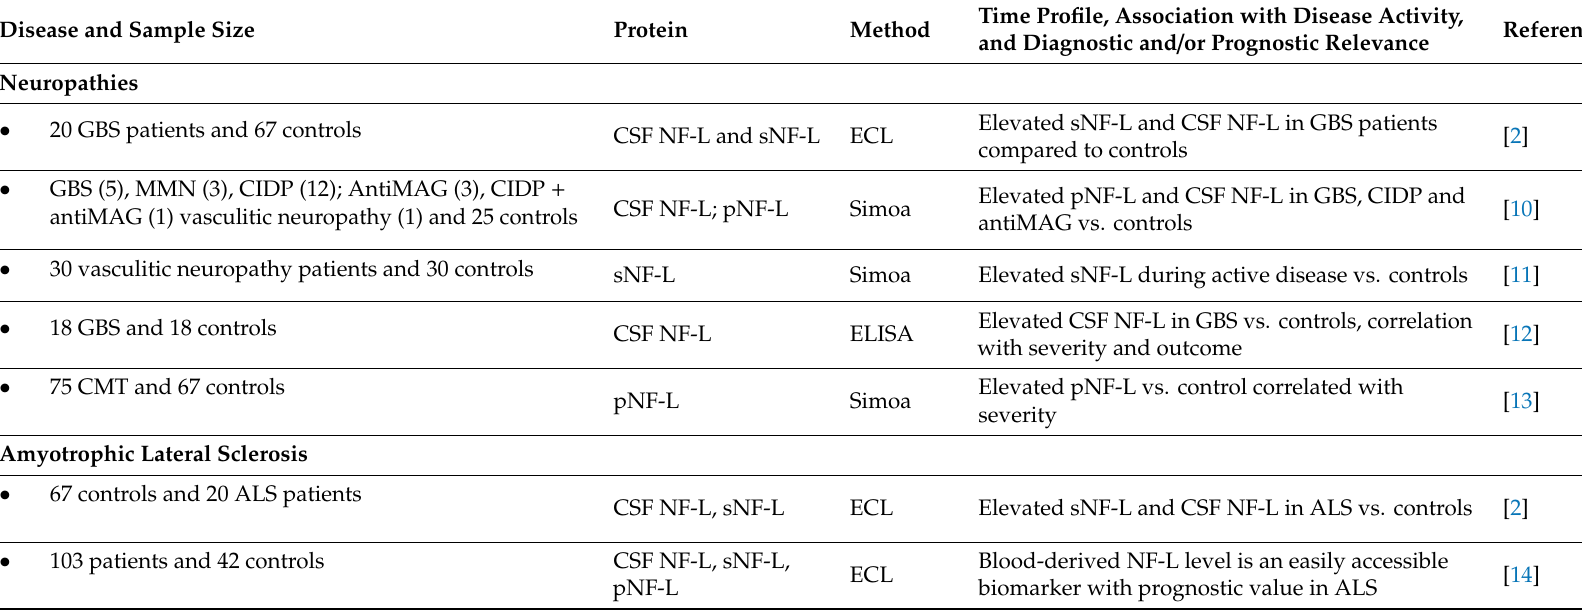
Table 1. Overview of neurofilaments as biomarkers of neurological disease. Abbreviations used in table: AD, Alzheimer’s disease; ADAD, autosomal dominant Alzheimer’s disease; AIS, acute ischemic stroke; ALS, amyotrophic lateral sclerosis; aMCI, amnestic mild cognitive impairment; aSAH, aneurysmal subarachnoid hemorrhage; CA, cardiac arrest; CADASIL, cerebral autosomal-dominant arteriopathy with subcortical infarcts and leukoencephalopathy; CBS, corticobasal syndrome; CeAD, cervical artery dissection; CIDP, chronic inflammatory demyelinating polyneuropathy; CMT, Charcot–Marie–Tooth; CSF, cerebrospinal fluid; ECL, electrochemiluminescence; FTD, frontotemporal dementia; GBS, Guillain–Barr é syndrome; GCS, Glasgow Coma Scale; HD, Huntington’s disease; HHT, huntingtin; HS, hemorrhagic stroke; MCI, mild cognitive impairment; MMN, multifocal motor neuropathy; MND, motor neuron disease; MS, multiple sclerosis; MSA, multiple system atrophy; NF-M, neurofilament medium chain; ON, optic neuritis; PD, Parkinson’s disease; pNF-L, plasma neurofilament light chain; p-pNF-H, plasma phosphorylated neurofilament heavy chain; PSP, progressive supranuclear palsy; ROSC, return of spontaneous circulation; RSSI, recent small subcortical infarcts; neurofilament light chain; SVD, small vessel disease; TIA, transient ischemic attack; WMH, white matter hyperintensities; WML, white matter lesions. Time Profile, Association with Disease Activity, Disease and Sample Size Protein Method and Diagnostic and / or Prognostic Relevance